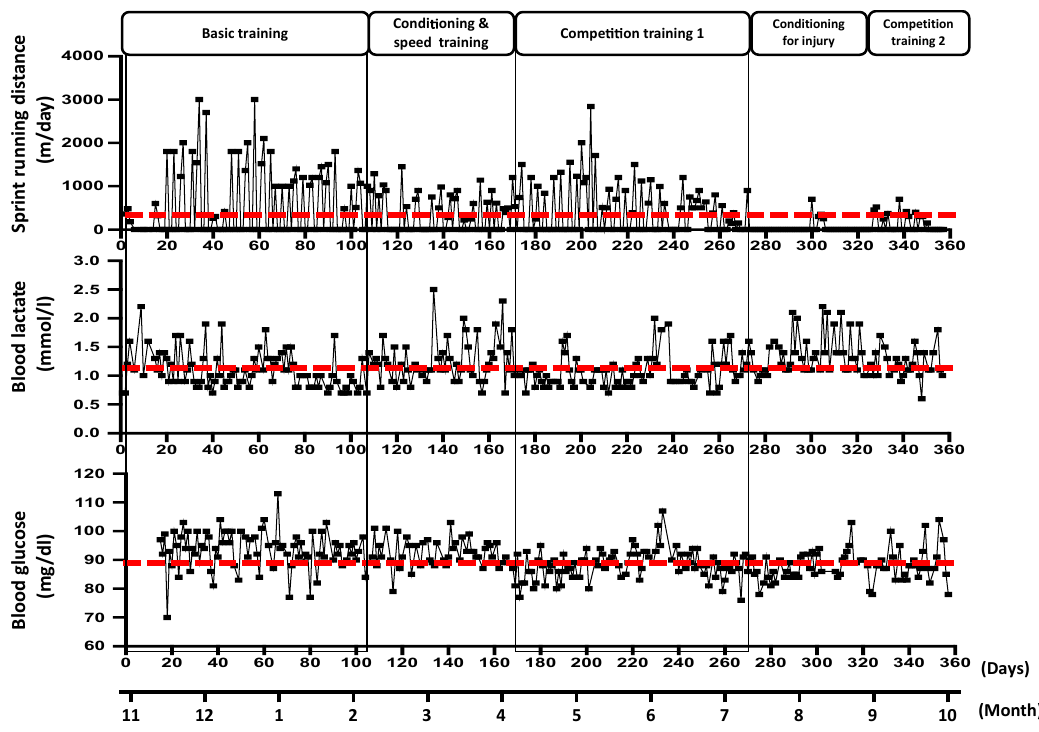
Figure 1. Sprint running distance (upper graph) and changes in daily morning blood lactate (middle graph) and glucose (lower graph) concentrations. The average value for all training period is shown by the red line.